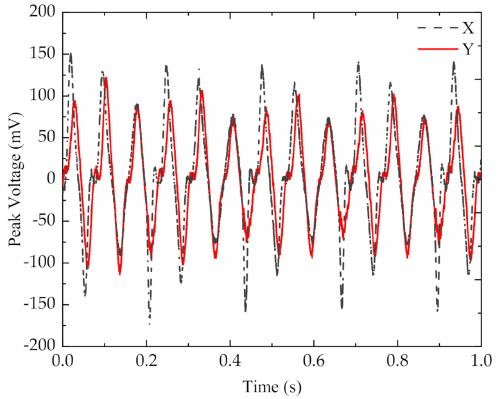
Figure 14. Electromagnetic energy harvester open-circuit output